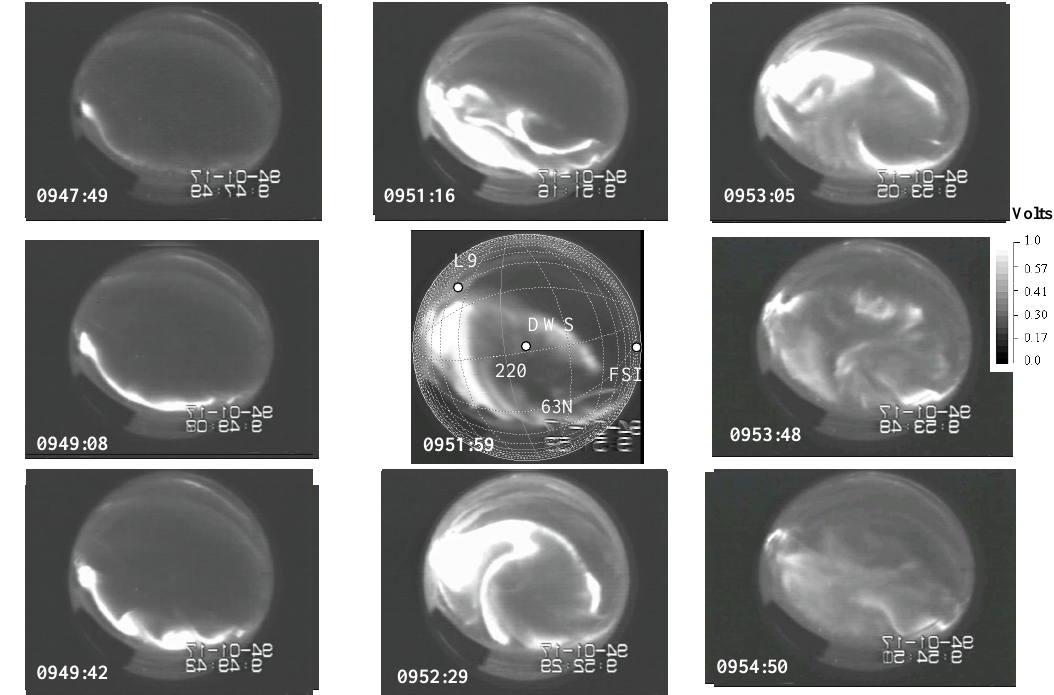
Figure 7. Nine all-sky images from 09:47:49 to 09:54:50UT for 17 January 1994. The brighter part of the auroras is in white. Geographic latitudes and longitudes are overlaid on the center image (09:51:59) using grids. Latitudes are plotted every one degree, while the longitudes are for every two degrees. The satellite footprints calculated by the IGRF, the optical station DWS, and the ground magnetometer station FSI are overlaid by white circles. East is to the right, west is to the left, north is up, and south is down. The geomagnetic coordinates are rotated 19.6 ◦ clockwise at DWS with respect to the geographic coordinates. The sequence sampled at ∼ 2s from 09:48:00 to 09:55:01UT is given in Animation_2 (see Supplement). Note that images in the animation were viewed anti-parallel to the field lines. East is to the left and west to the right in the